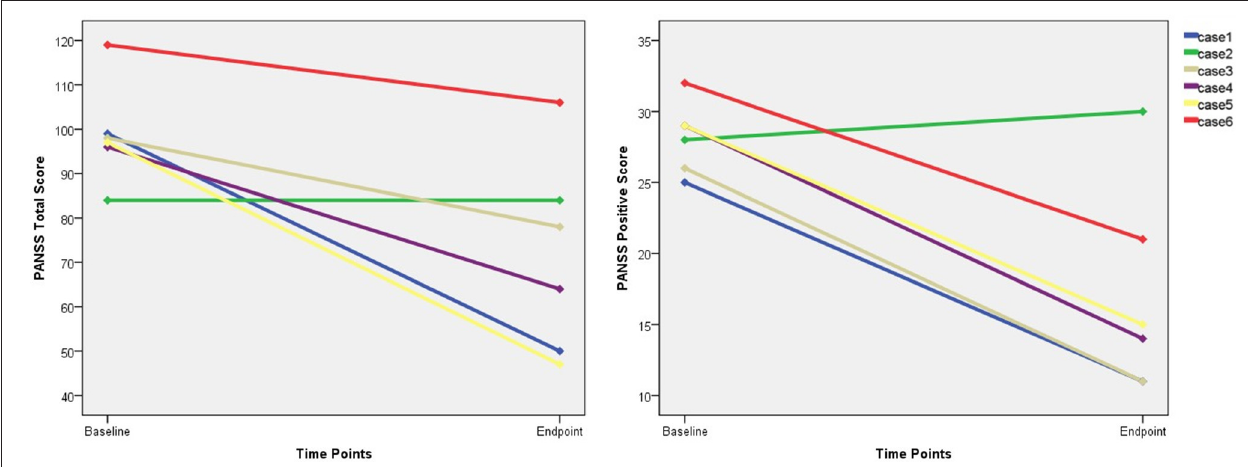
FIGURE 2 | The changes of PANSS total score and positive score. PANSS, Positive and Negative Syndrome